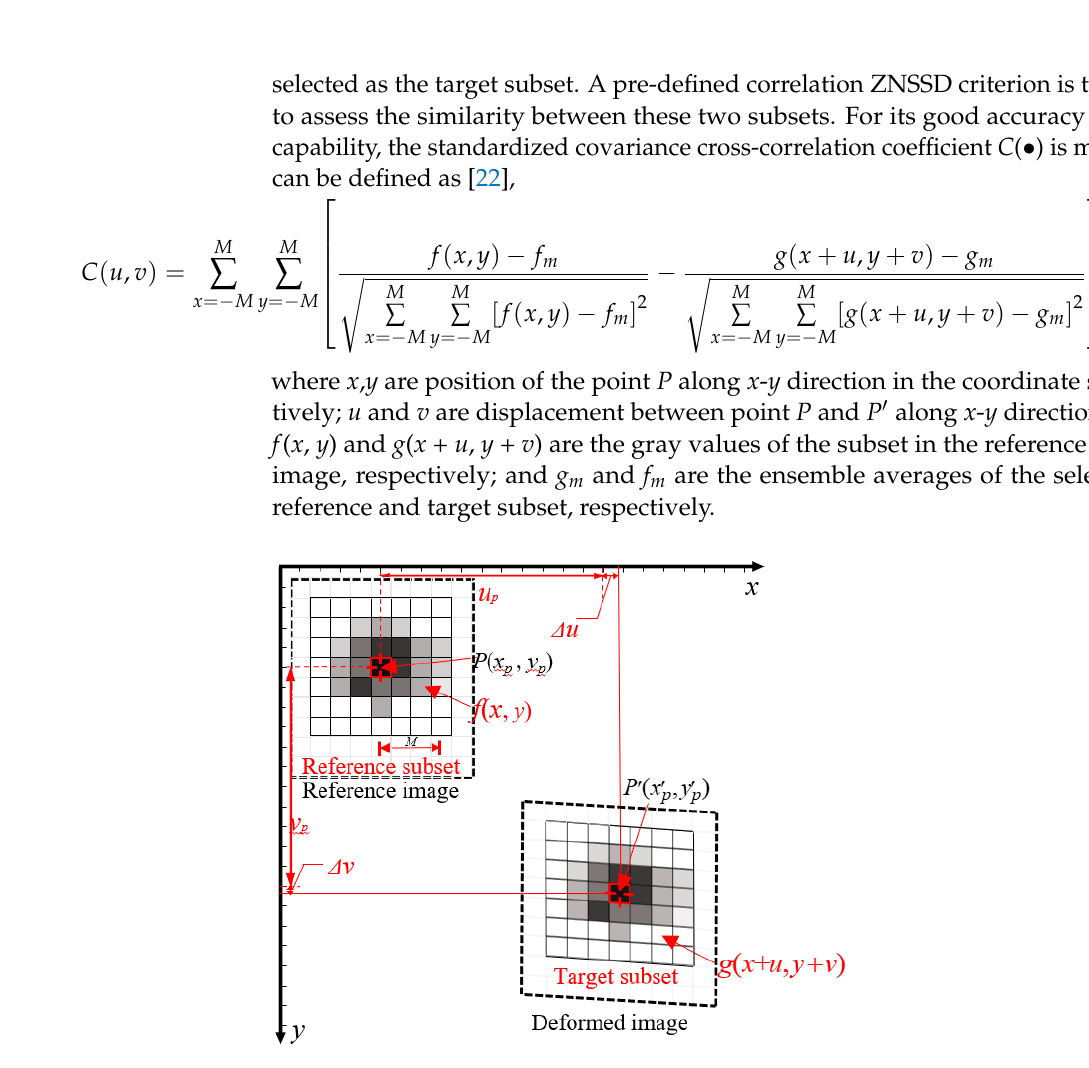
Figure 1. Displacement identification principle of two-dimensional DIC during integral pixel step.